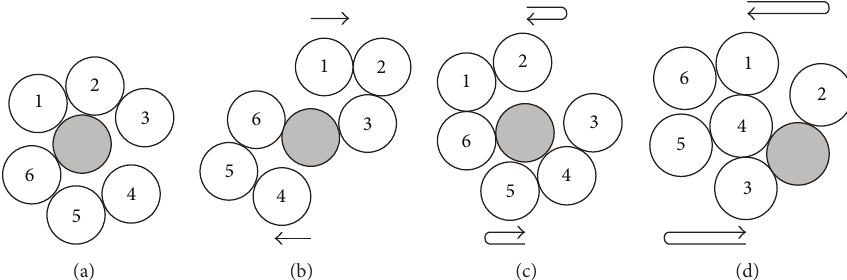
Figure1:Yieldingmechanismsinanattractiveparticulate glass ,viewedalongthevorticitydirection.(a)Theoriginalunshearedconfiguration. The shaded particle has particles 1–6 as topological neighbours and is bonded to particles 1, 2, and 6. Under small shear strains, the bonds are stretchedbuttheparticlesstayinthesameconfiguration.(b)Breakageofbondsaboveathresholdshearstrain.(c)Afteronecycleofoscillatory shear, the shaded particle is now bonded to different particles. (d) Above another threshold in oscillatory shear strain, the identity of the topological neighbours around the shaded particle is changed and the glass is melted and becomes liquid-like. (Reprinted with permission from Pham et al. [59]. Copyright 2008, The Society of Rheology.) (See also [61,